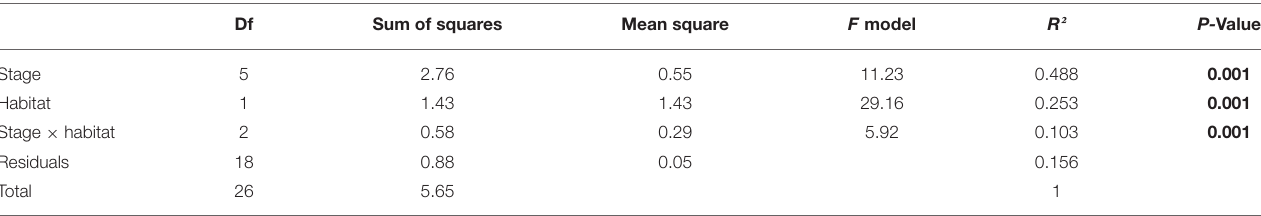
TABLE 1 | PERMANOVA of Bray-Curits dissimilarity between samples collected at different developmental stages (fertilized egg, trochophore, D-stage, veliger, pediveliger, and spat), habitat (larvae or rearing water), and their interactions. Df Sum of squares Mean square F model R ² P- Value Stage 5 2.76 0.55 11.23 0.488 0.001 1.43 1.43 29.16 0.253 0.001 0.58 0.001 Residuals 0.88 0.156